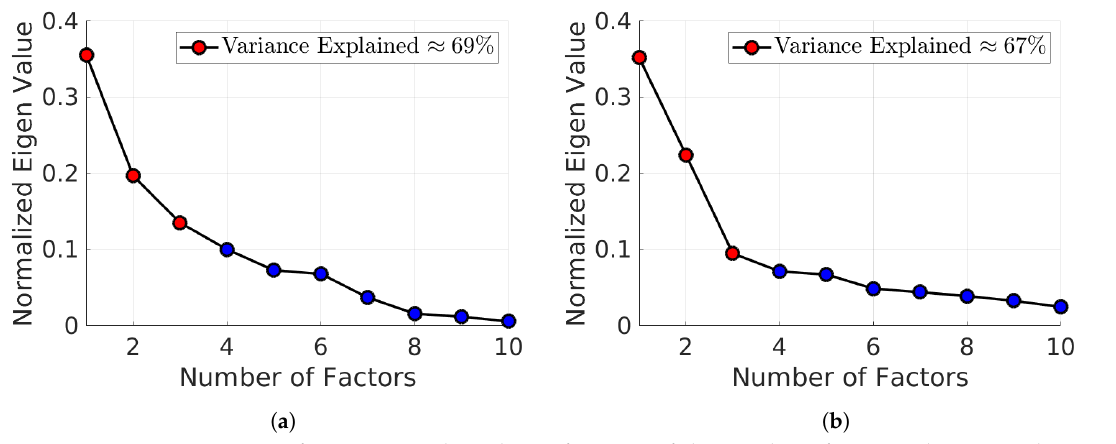
Figure 1. Percentage of variance explained as a function of the number of eigen values. For the BQREB and the BSSA-10, three eigen values explain more than 65% of the total variance. ( a ) BQREB. ( b ) BSSA-10.